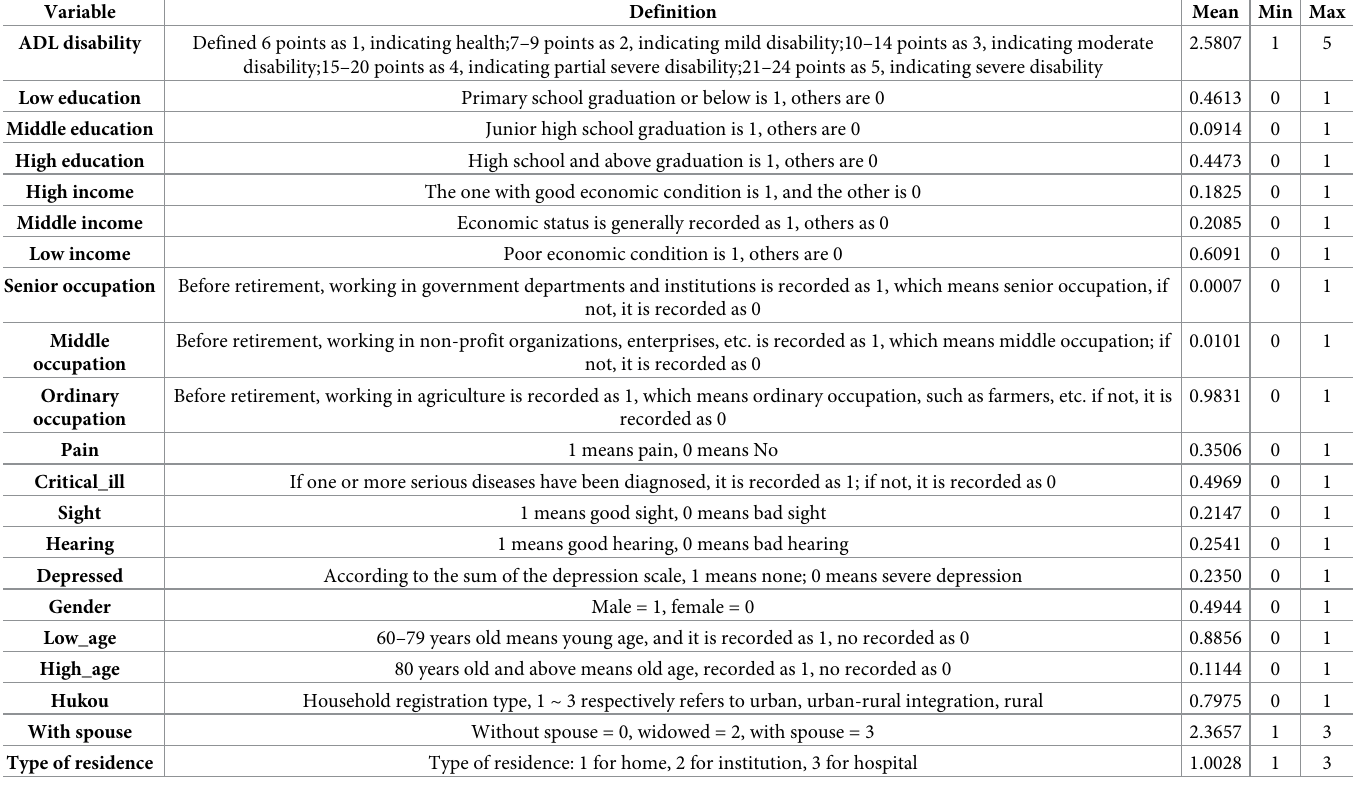
Table 1. Variable definition and descriptive